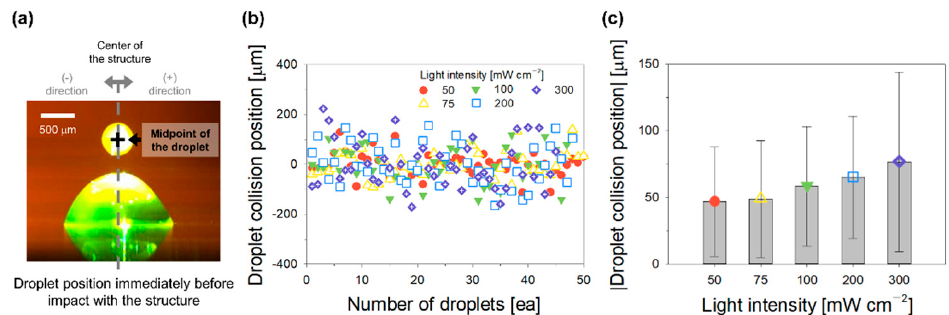
Figure 2. Investigation of droplet directionality. ( a ) Photograph acquired immediately before a droplet collided with the structure; ( b ) the distribution, ( c ) average, and standard deviation of droplet collision positions with respect to the light intensity.